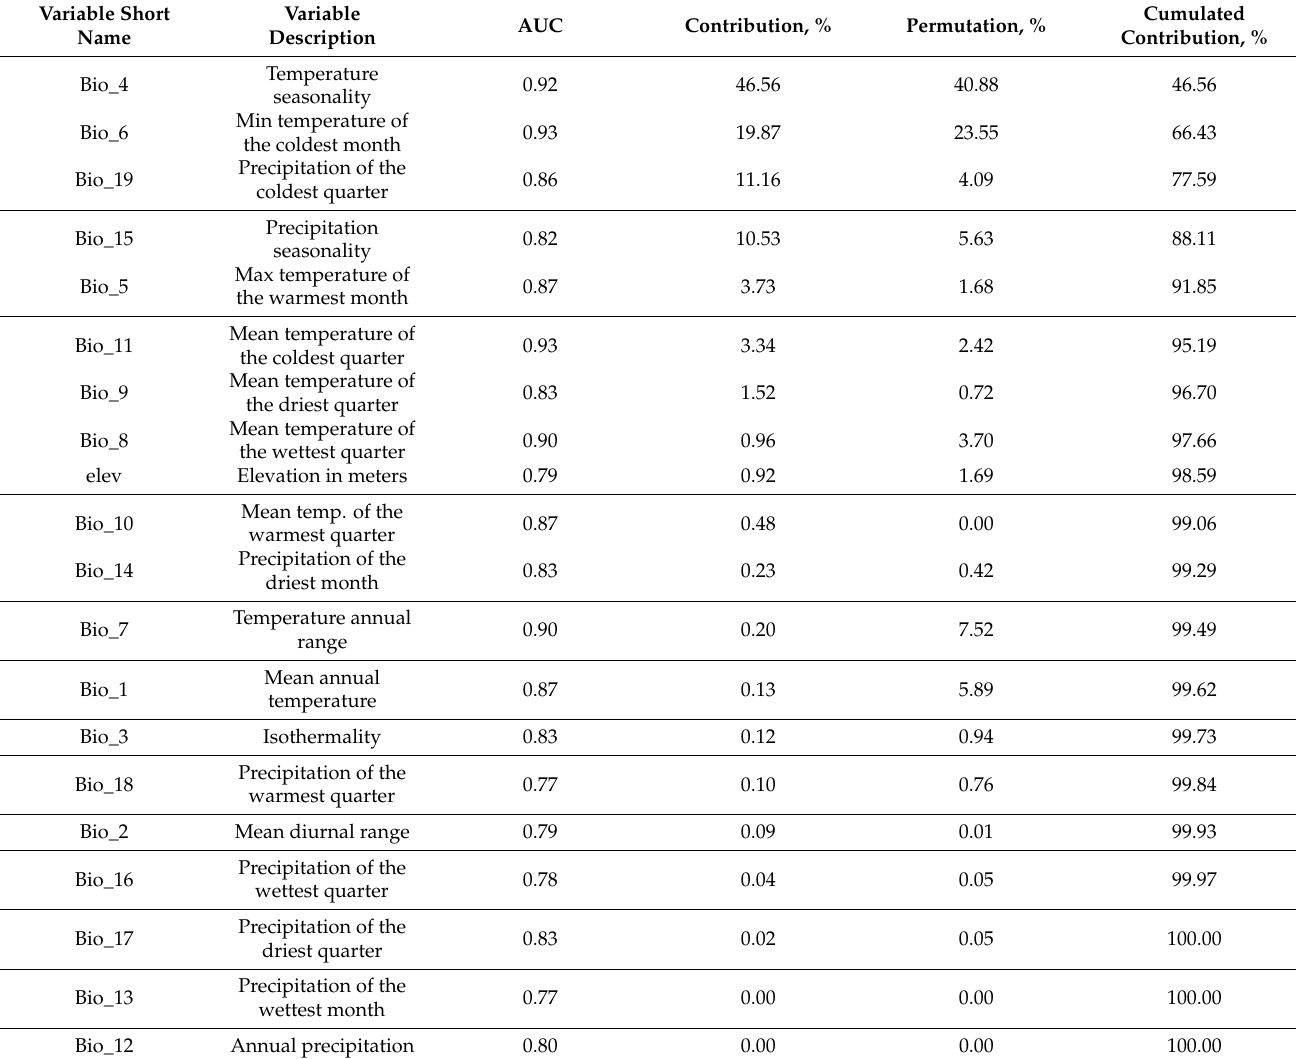
Table 6. Bioclimatic variables with the greatest influence on the MaxEnt probability of EAB presence. Variables are listed in order of descending